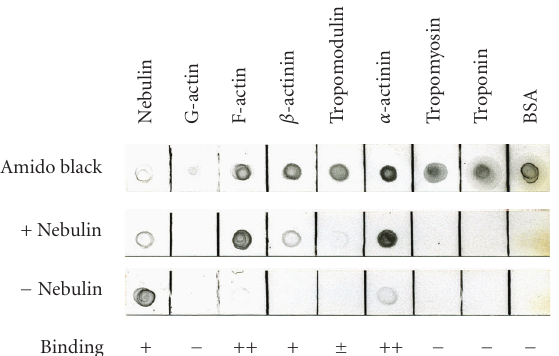
Figure 7: Binding of thin filament proteins to purified nebulin by far western blot analysis. Proteins (0.2 μ g) adsorbed onto a nitrocellulose membrane were incubated in nebulin reaction solution (0.18M KPO 4 , 0.1mM MgCl 2 , 0.1 mM EGTA, and 0.5 M urea, pH 7.0) for 20 hours at 4 ◦ C. Amido black: amido black staining; +nebulin: incubation in nebulin (15 μ g/ml), − nebulin: incubation in reaction solution